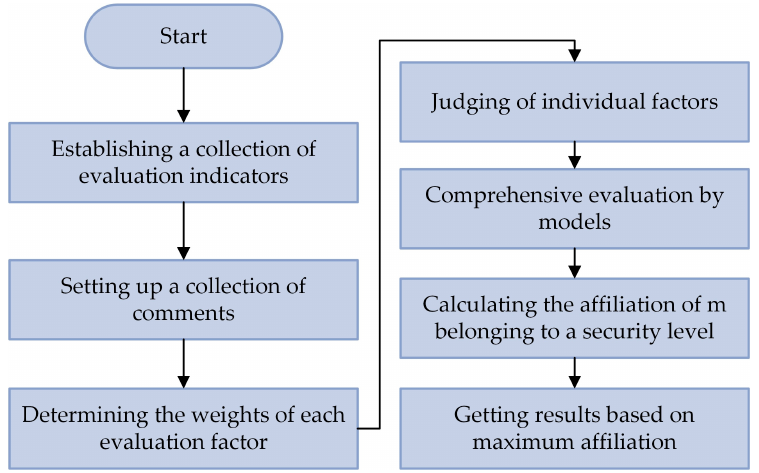
Figure 3. Flow chart of fuzzy comprehensive evaluation method of charging equipment safety. Table 1. Correspondence between charging equipment health degree and safety grade. m Safety Level